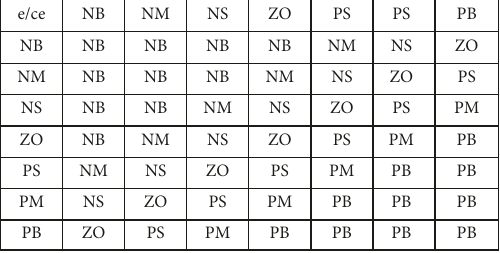
Figure 4: Fuzzy logic membership functions.